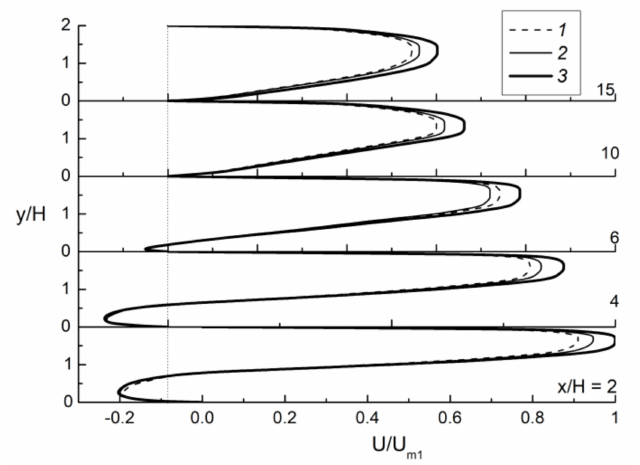
Figure 12. Profiles of mean axial fluid velocity in bubbly flow in the backward-facing step. 1— β = 0 (single-phase fluid flow, other conditions being identical), 2—2%, 3—5%.